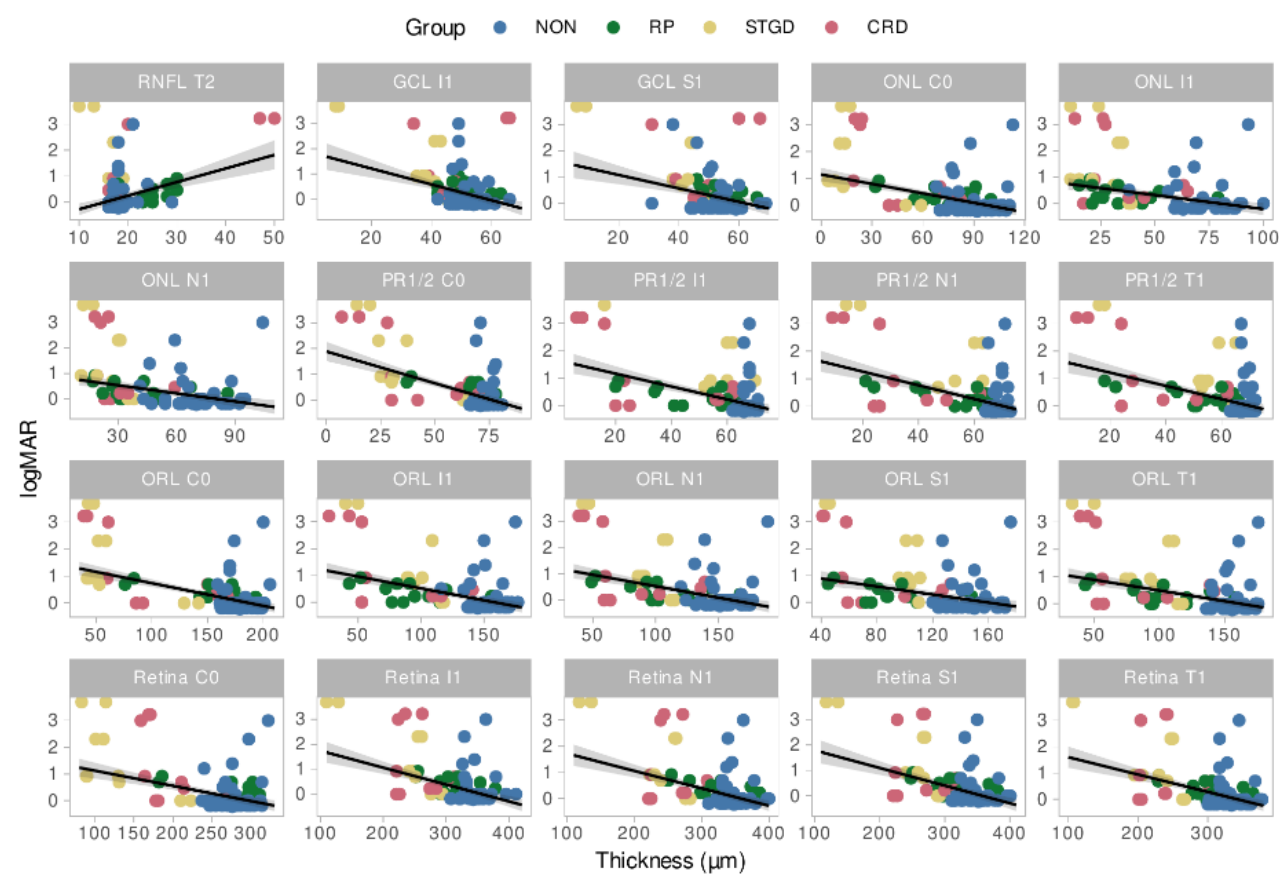
Figure 4. Relation between LogMAR VA and layer thickness for the 20 most significant subfields and layers. NON = Controls, STGD = Stargardt disease, RP = Retinitis pigmentosa, CRD = Cone rod dystrophy, Retina = Total retina thickness, RNFL = Retinal nerve fiber layer, ONL = Outer nuclear layer, PR1/2 = photoreceptor layer 1 and 2, GCL = ganglion cell layer, ORL = Outer retinal layers.